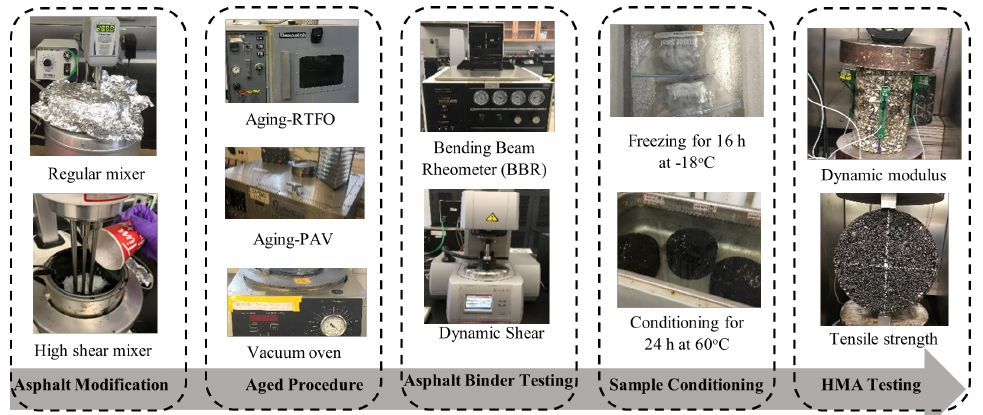
Figure 2. Experiment and